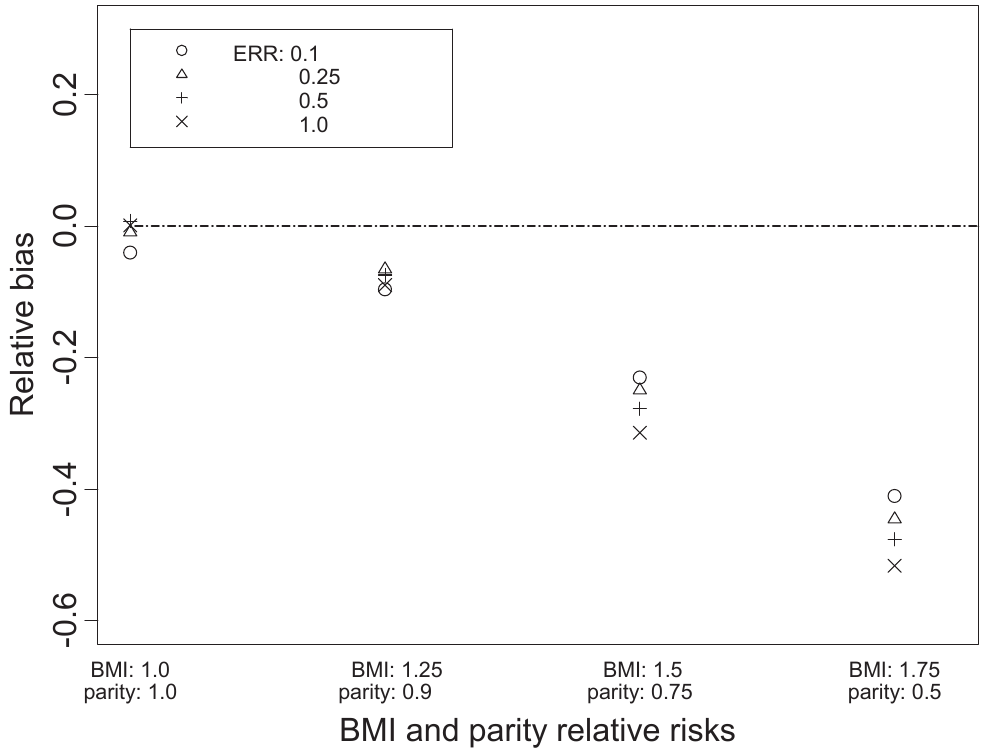
BMI and parity relative risks Figure 1. Simulated relative bias in the estimated excess relative risk (ERR) for exposure from a fi t of model (2), as a function of true excess relative risk and various combinations of the relative risk (RR) of omitted covariates: body mass index (BMI) and parity. Cohort size N = 20,000, baseline prevalence p 0 = 0.05, and control:case sampling ratio 2:1. Table 2. Simulated e ff ect of omitting a continuous covariate with either detrimental or protective e ff ect a With covariate omitted With covariate included Relative risk for omitted covariate Median Std dev Median Std dev ERR model, ERR for radiation